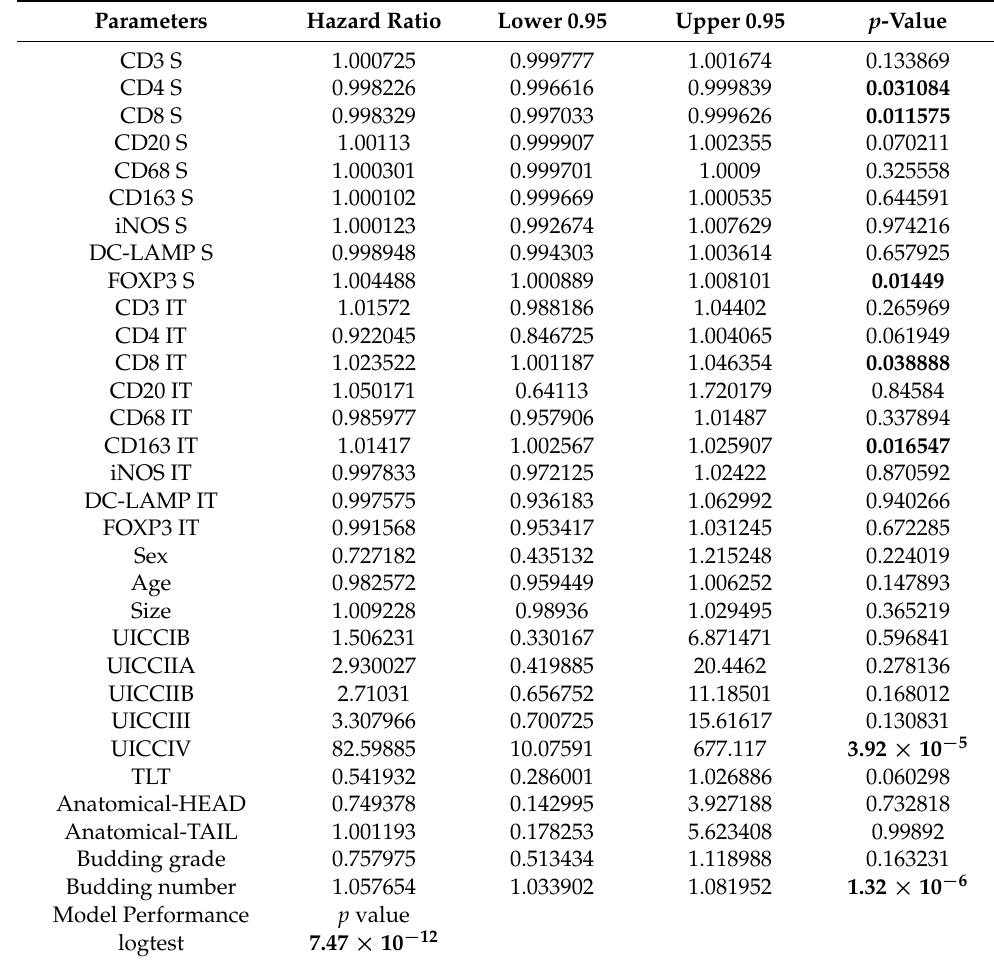
Table 2. Multivariate Cox regression analysis with model performance is